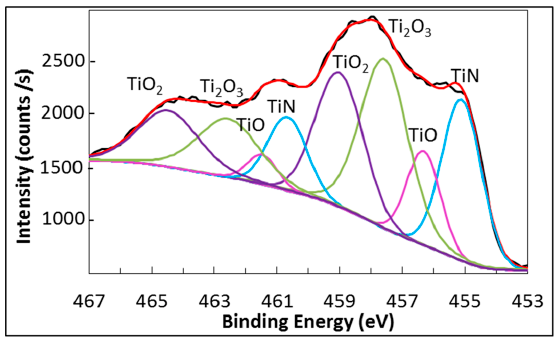
Figure 6. TiAlN1 after 40 burner rig cycles up to 850 °C: fitting of Ti2p peaks.